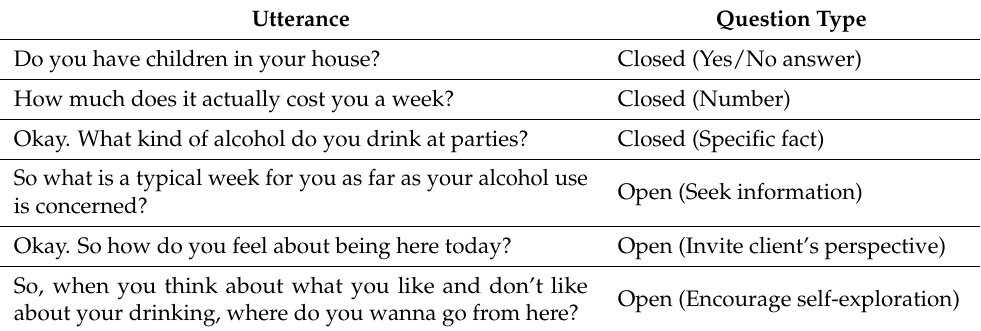
Table 5. Example labelling for therapist Question from the dataset. Utterance Question Type